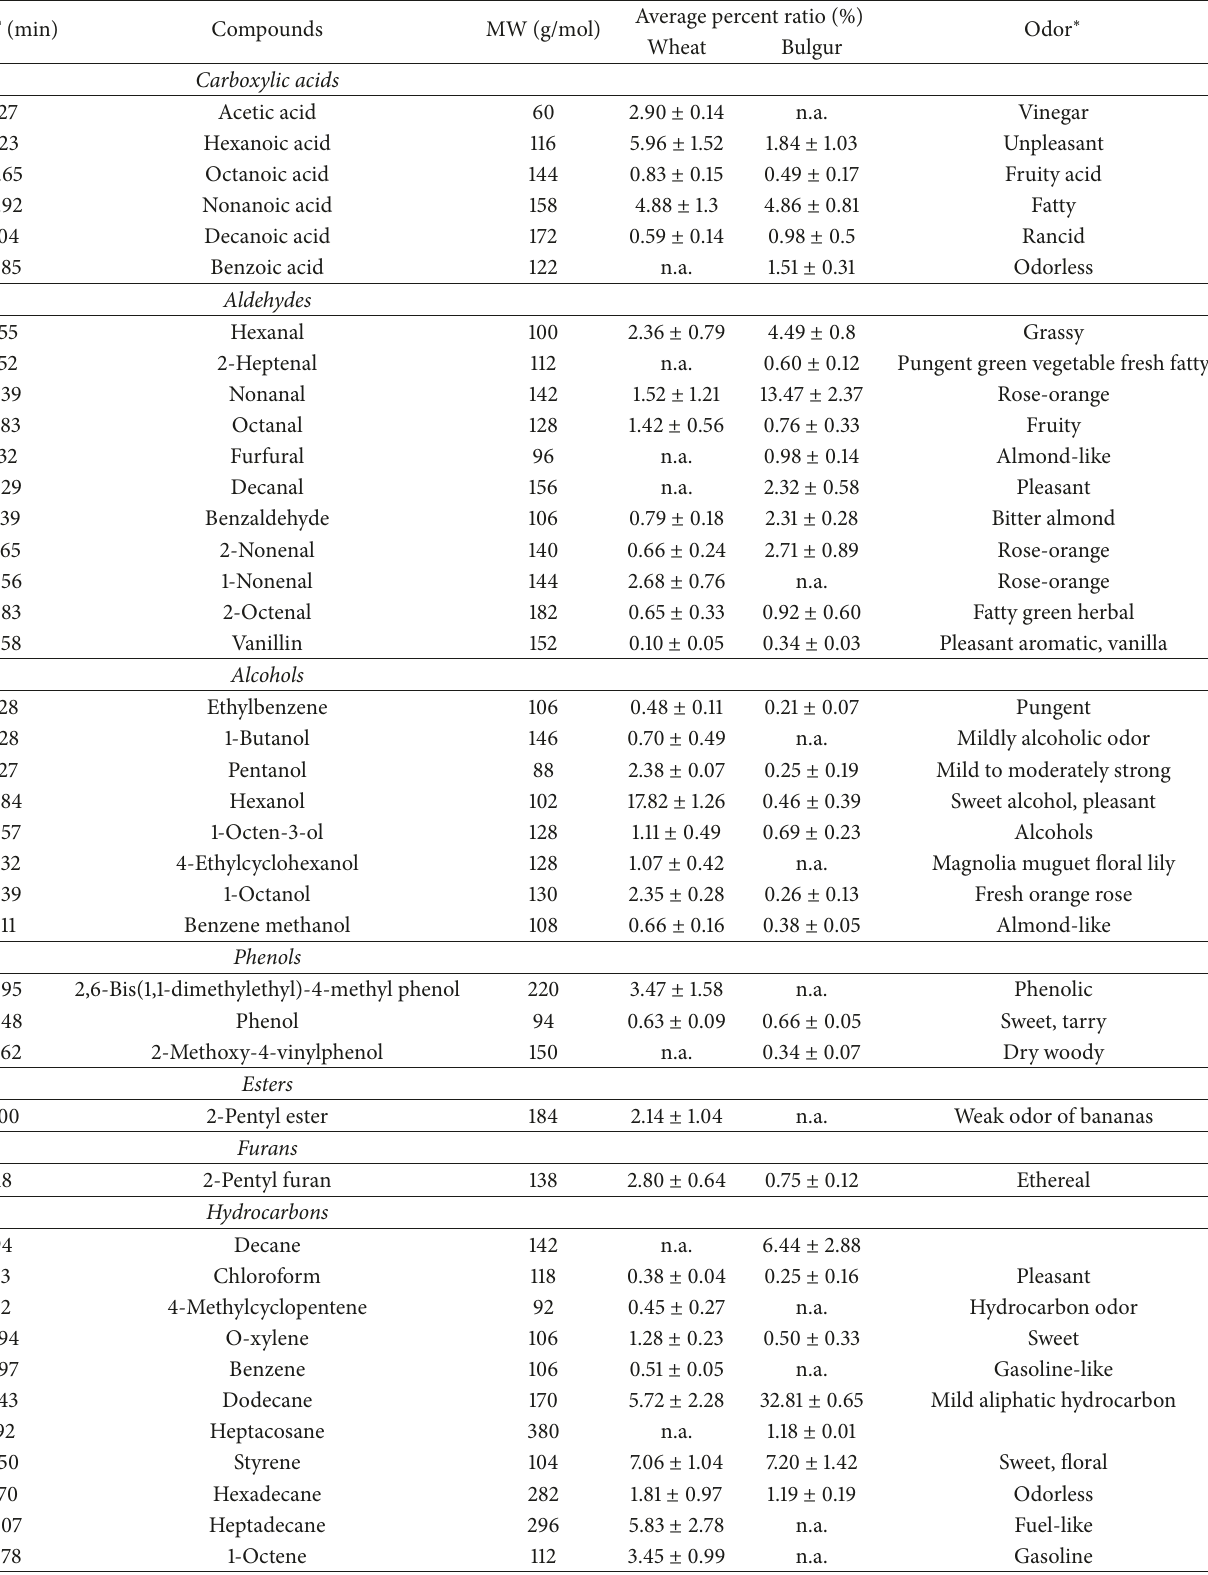
Table 3: Volatile flavor compounds of Durum wheat and Antep type